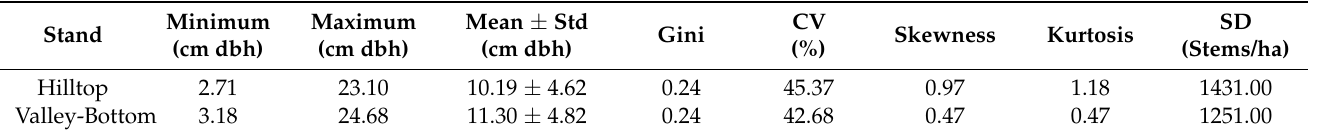
Table 1. Statistics of the diameter distributions of the Tectona grandis stand in the Valley-Bottom and Hilltop habitats of the Omo Forest Reserve.